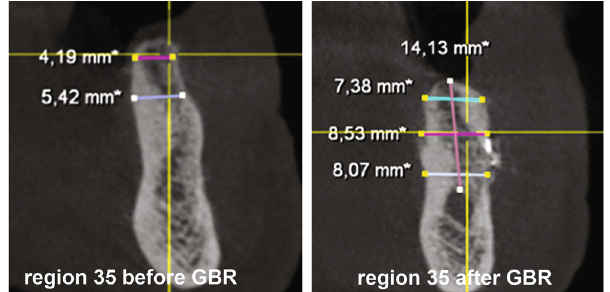
Figure 22: DVT — sections; implant position region 35 before and after GBR.